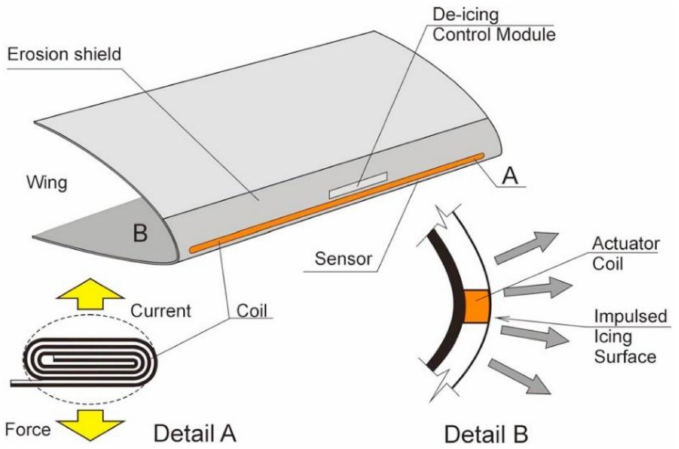
Figure 3. SchematicoftheElectro-MechanicalExpulsionDeicingSystems(reproducedfromHuangetal.[39] with permissions from